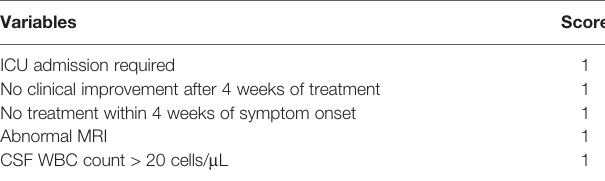
TABLE 1 | The anti-N-Methyl-D-Aspartate Receptor (NMDAR) Encephalitis One- Year Functional Status (NEOS) score.